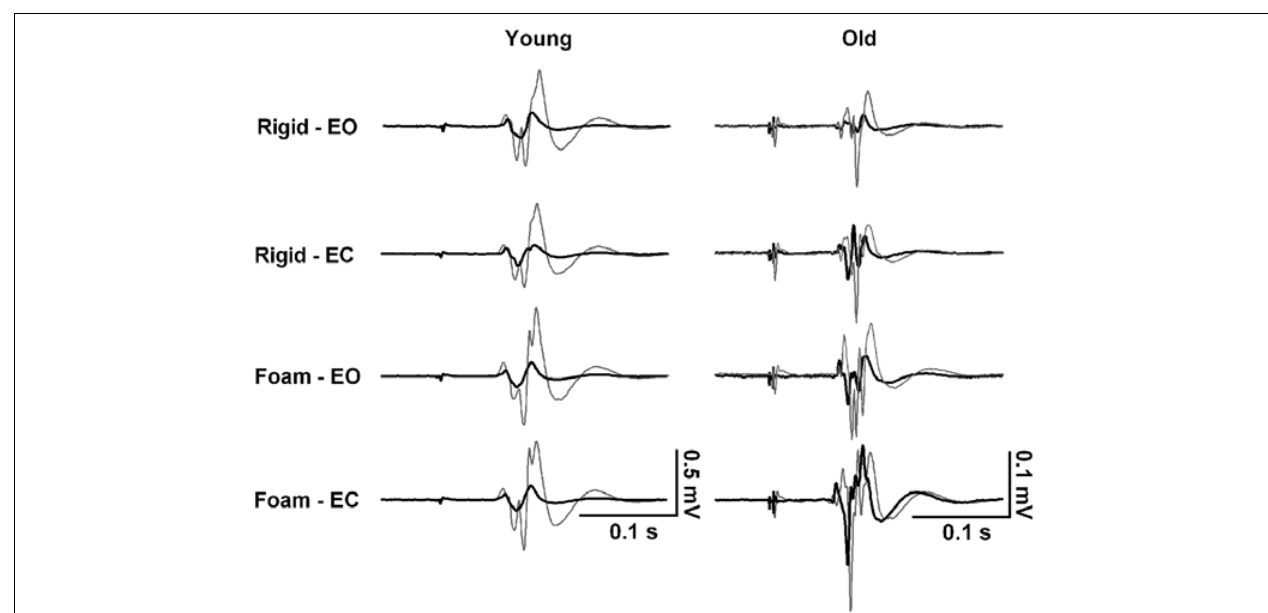
unconditioned test pulse (thing gray line) and to a conditioned test pulse (thick black line) at 2.5 ms interval. Note the absence of modulation of short interval intracortical inhibition (SICI) across the four conditions in the young subject, in contrast to the old subject who decreases SICI when sensory conditions are